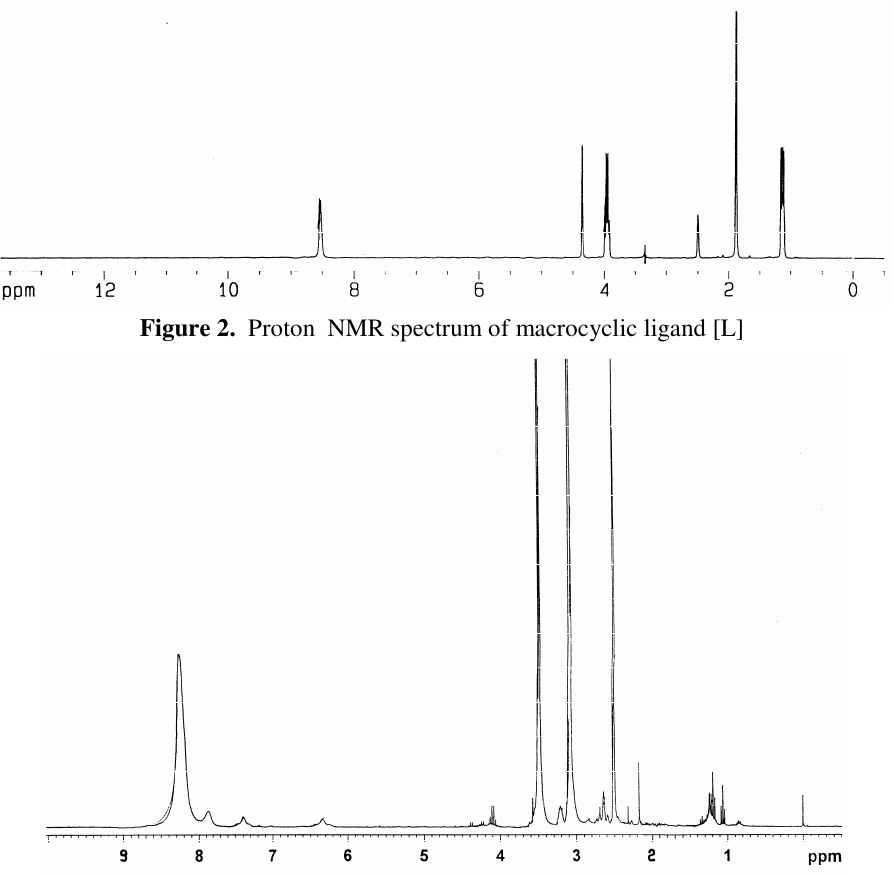
Figure 2. Proton NMR spectrum of macrocyclic ligand [L]